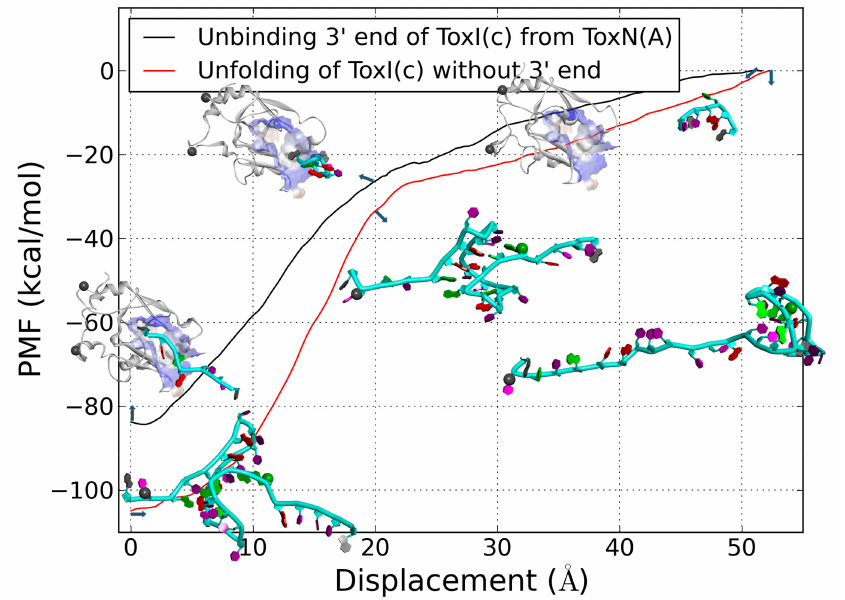
Figure 10. PMF curves of the unbinding of the 3 (cid:48) terminus of ToxI(c) from ToxN(A) and the unfolding of ToxI(c) without the 3 (cid:48) terminus. Insets: the starting, at displacement 20 Å, and the last structures are shown. The structures of ToxN(A) are shown in white color with new cartoon representation, as well as ToxI(c) in cyan with tubes representation and the nucleobase with rings. The atoms fixed in the SMD simulations are shown in grey color with